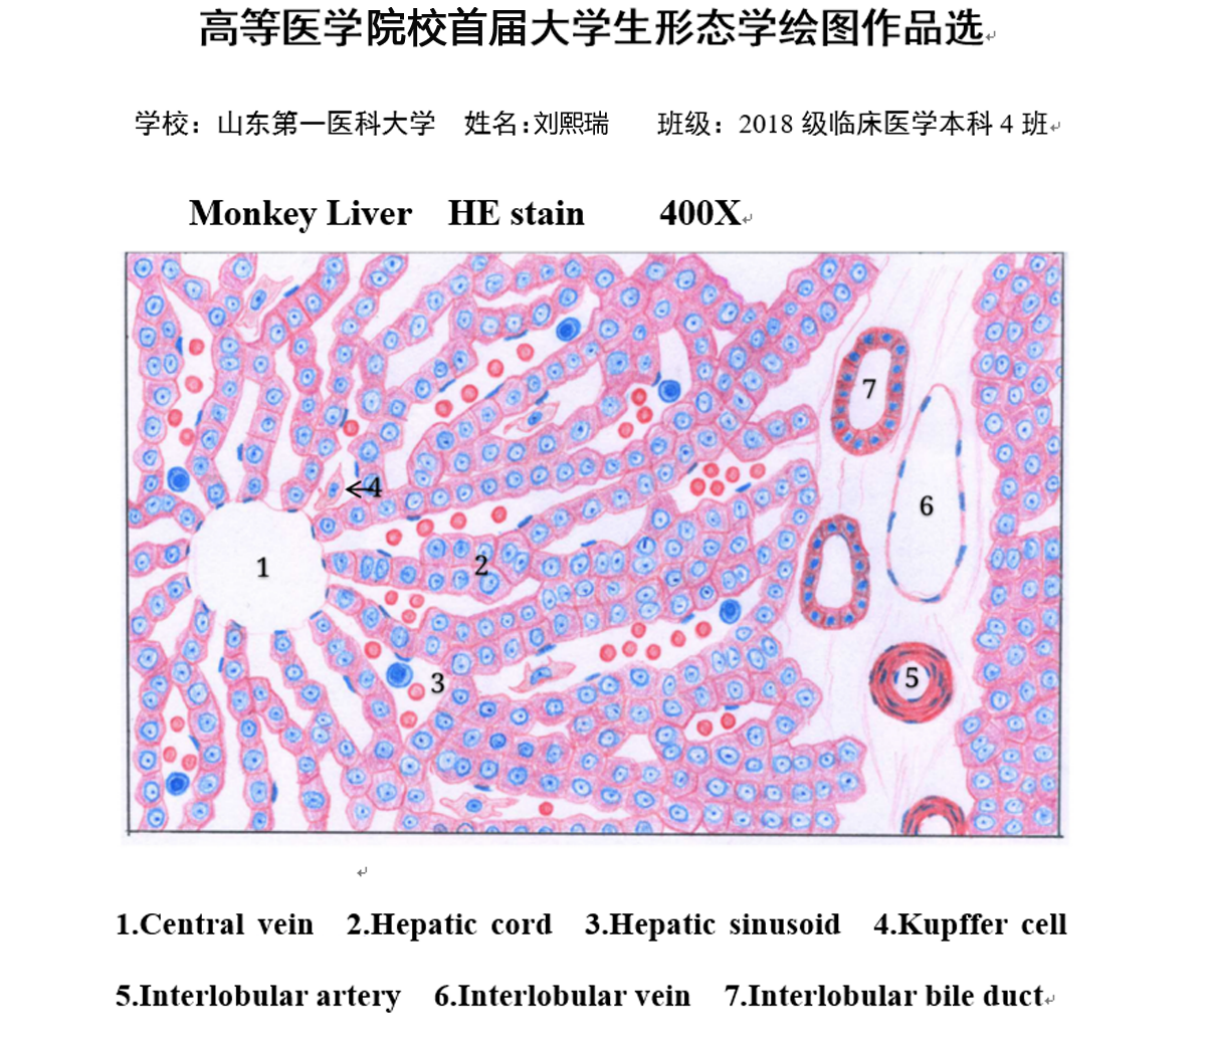
Figure 2. The winning entry in the drawing competition of the Histology and Embryology